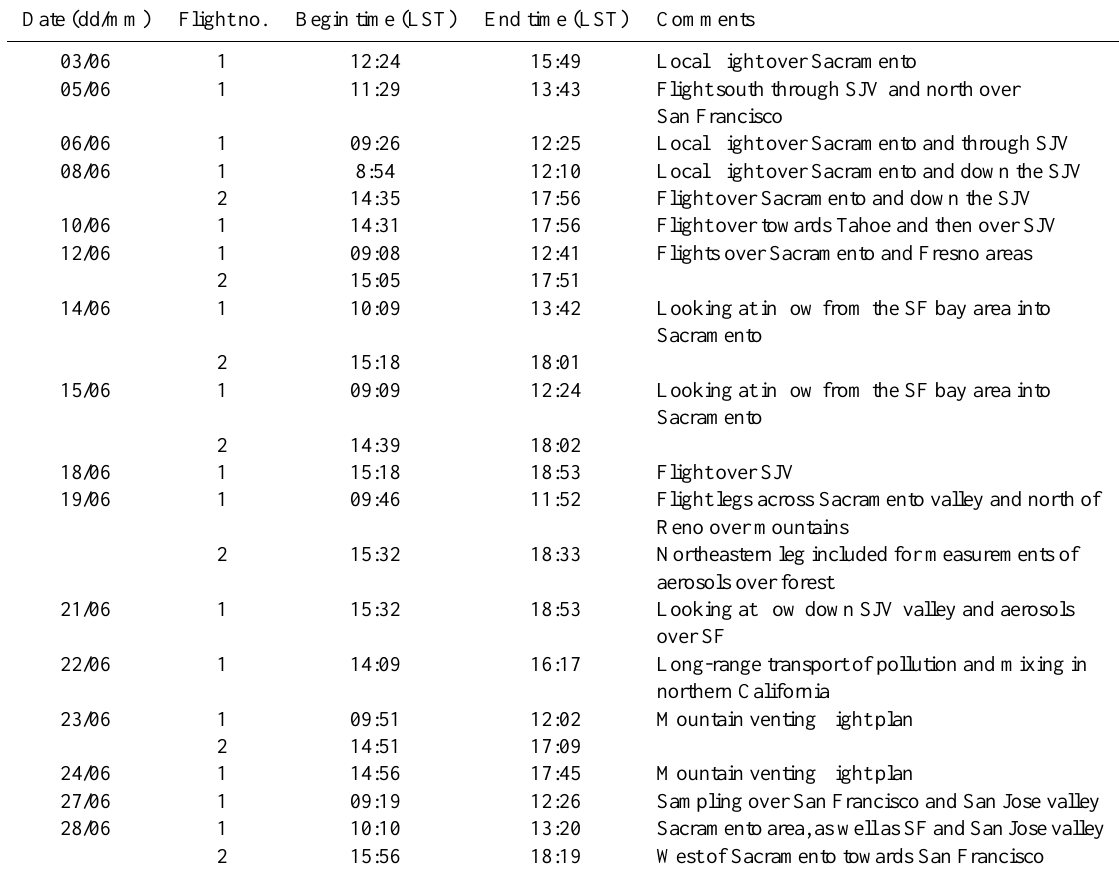
Table 2. Summary of HSRL flights during